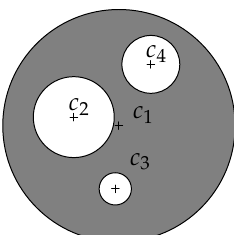
Figure 1. A sphere world bounded by an outer circle of center c 1 and three non overlapping inner circles of centers c 2 , c 3 and c 4 ,